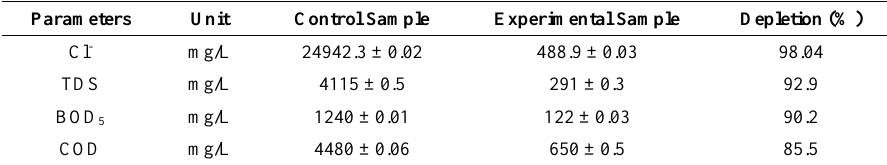
Table 3. Pollution load generated in soaking operation